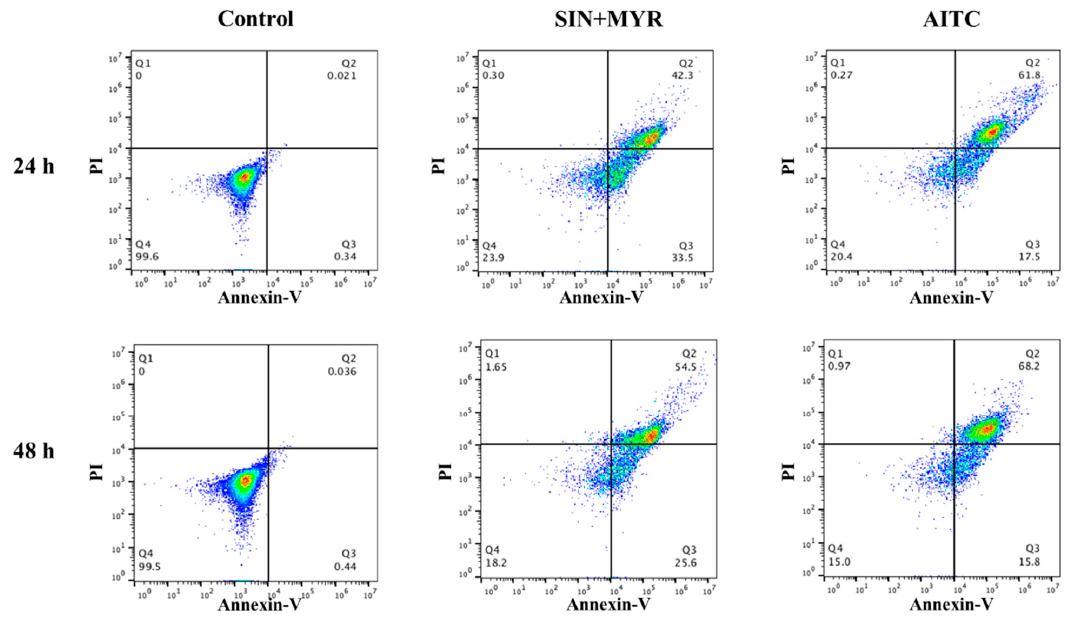
Figure 7. Flow cytometry analysis of A549 cells labeled with Annexin-V and PI for control, SIN+MYR, and AITC groups. The top panel shows the bivariate density plots after 24 h, and the bottom panel shows bivariate density plots after 48 h. The Caspase-3/7 green detection reagent has DEVD (four amino acid) peptide conju- gated with green dye (excitation/emission: 503/530 nm) with the ability to bind with nu-